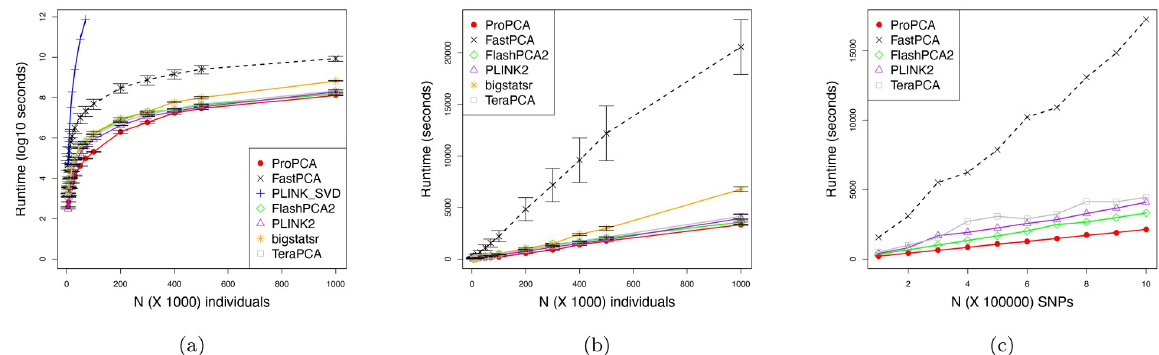
Fig 1. ProPCA is computationally efficient. Comparison of runtimes over simulated genotype data varied over individuals and SNPs. Figures 1a and 1b display the total runtime containing 100, 000 SNPs, six subpopulations, F st = 0.01 and individuals varying from 10, 000 to 1, 000, 000. We report the mean and standard deviation over ten trials. Figure 1b compares the runtimes of all algorithms excluding PLINK_SVD which could only run successfully up to a sample size of 70, 000. Figure 1c displays the total runtime containing 100, 000 individuals, six subpopulations, F st = 0.01, and SNPs varying from 10, 000 to 1, 000, 000. All methods were capped to a maximum of 100 hours and a maximum memory of 64 GB and run using default settings. We were unable to include bigstatsr in the SNP benchmark as it does not allow for monomorphic SNPs.